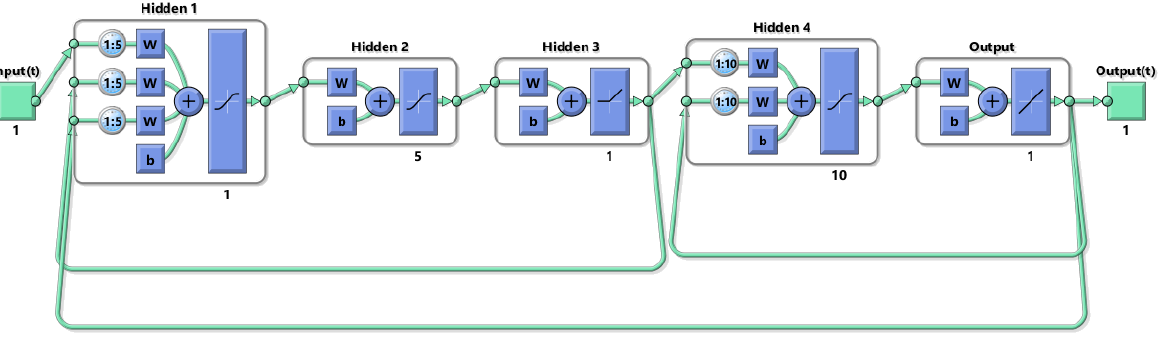
Figure 27. Reference model controller network.